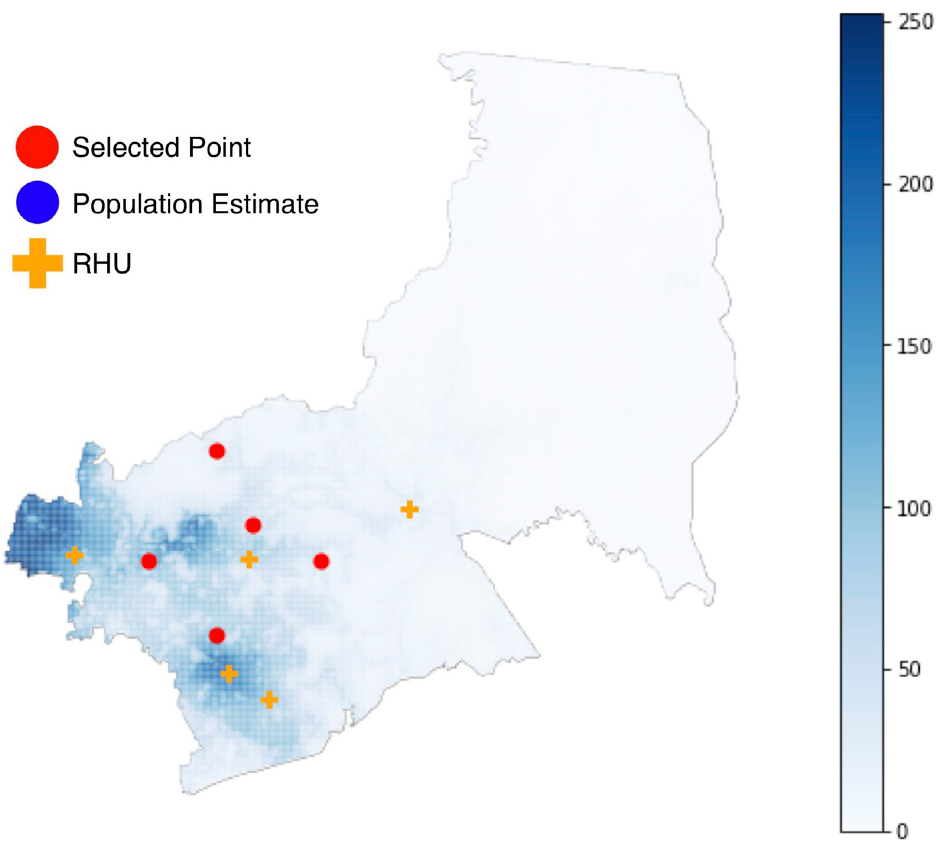
Fig 6. Optimal facility locations for 5 RHUs using Metric